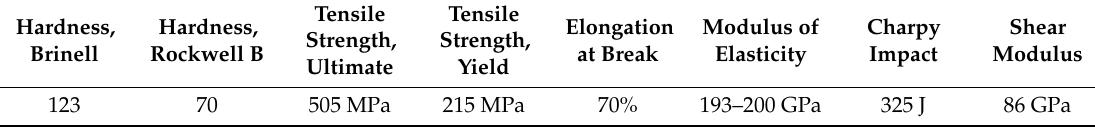
Table 3. Mechanical composition of the work piece material (Stainless Steel